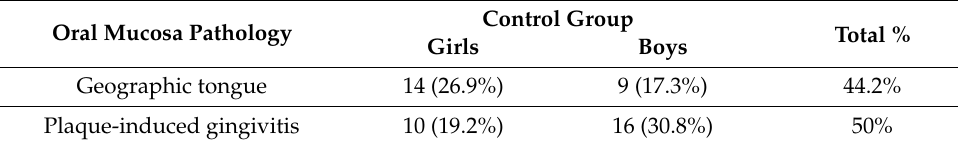
Table 4. Oral mucosa pathologies present in persons representing the control